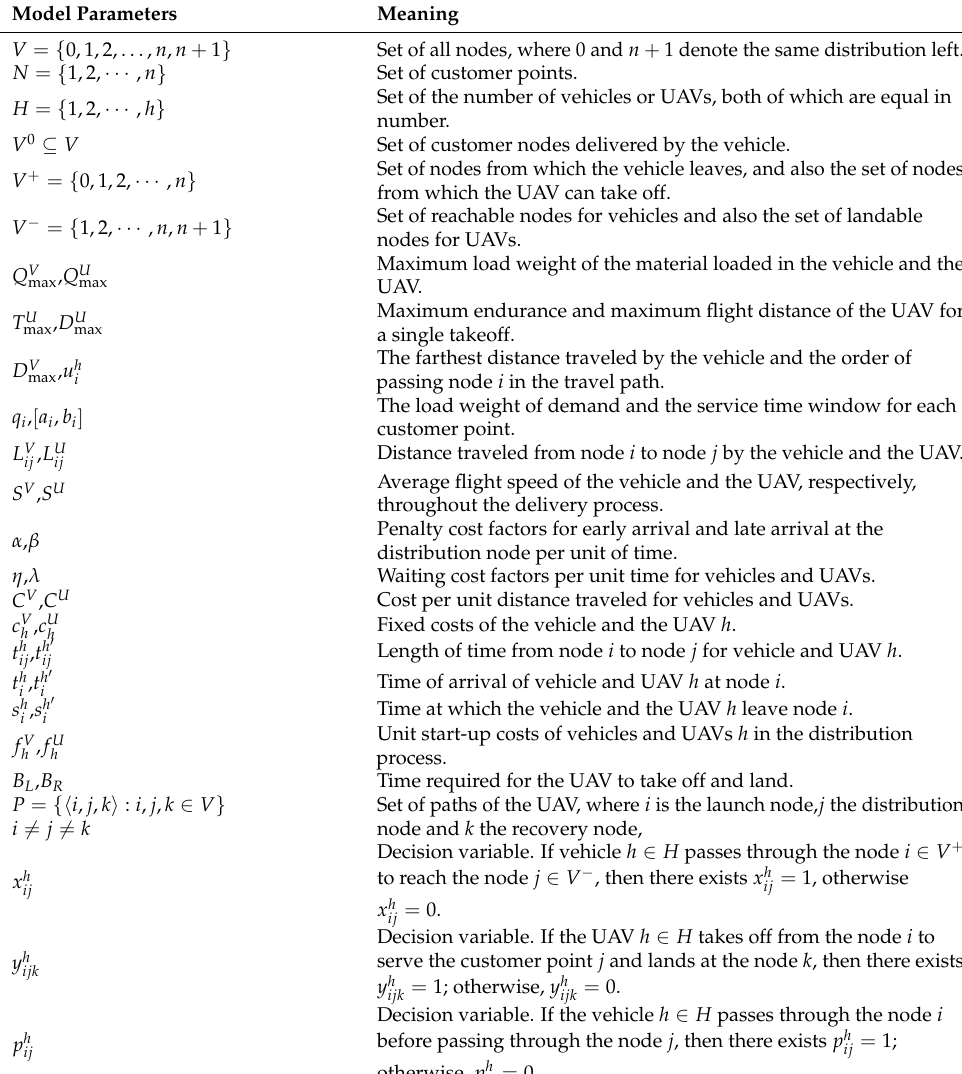
Table 1. Model parameters and their